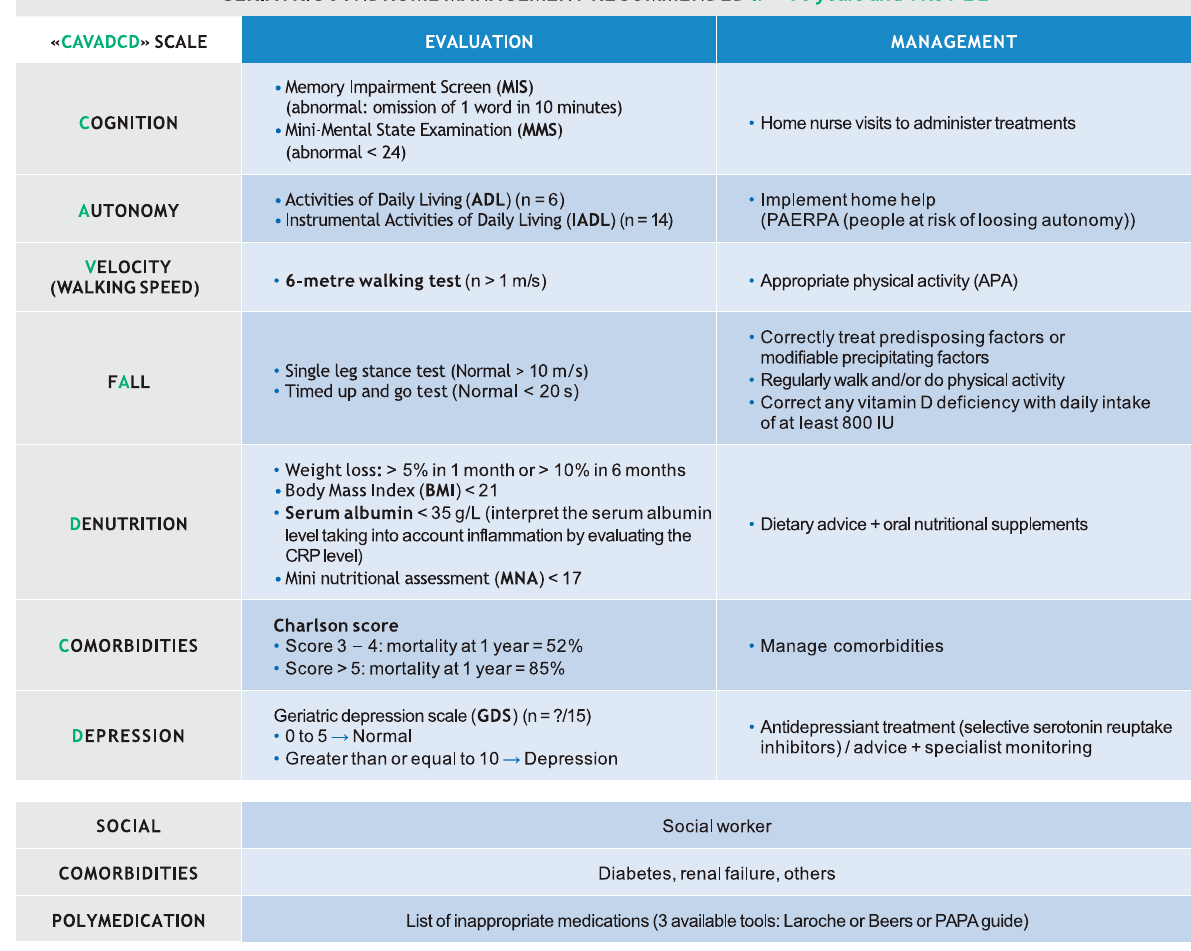
Figure 5. Geriatric syndrome management. This figure was developed using expert consensus, guidelines and recommen- dations [75–84] , and specific studies [85] .